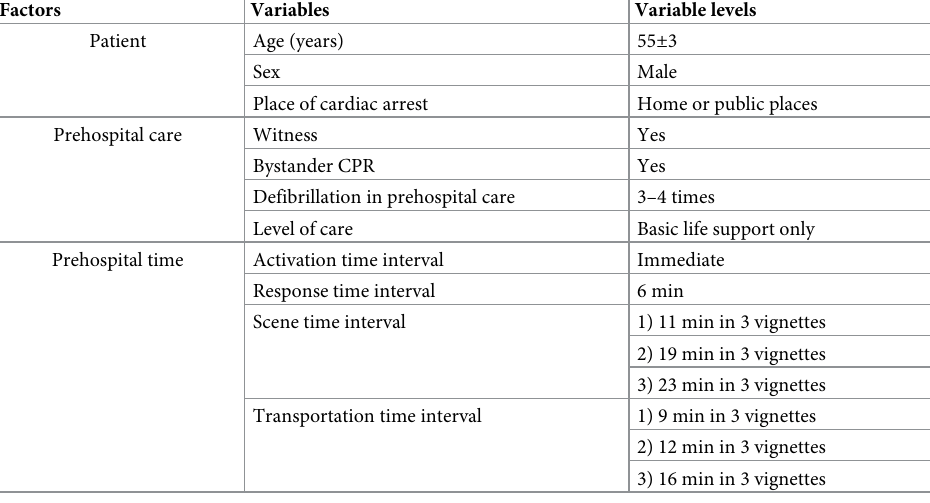
Table 1. Factors and variables as described in the